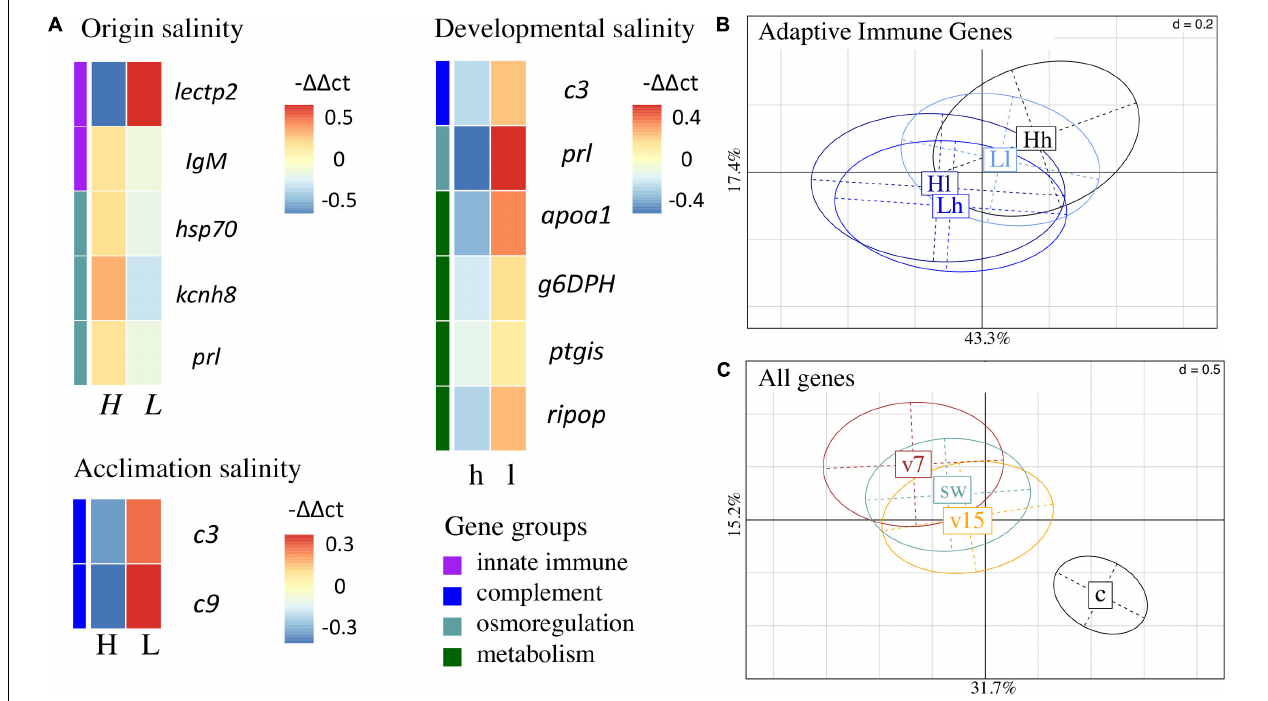
FIGURE 8 | Gene expression patterns of juveniles. (A) Non-hierarchical gene expression heatmap for genes showing differential expression (- (cid:49)(cid:49) Ct) in response to origin salinity , acclimation salinity or developmental salinity . Genes are sorted by gene groups which are assigned with different colors (purple: innate immune system, blue: complement system, turquoise: osmoregulation, green: metabolism). (B) Principal component analysis (PC1: 43.3%; PC2: 17.4%) of adaptive immune genes for significant interaction between parental acclimation salinity [H – high (15 PSU), L – low (7 PSU)] and developmental salinity (h, l). Four out of seven adaptive immune gene were upregulated ( Supplementary Figure 13 ), when parental acclimation salinity and juvenile developmental salinity did not match, i.e., Hl and Lh, compared to a matching acclimation and developmental salinity , i.e., Hh and Ll [PERMANOVA, adaptive F (1,523) = 2.6, p = 0.034]. The confidence ellipse explains 20% of the variability. (C) Principal component analysis (PC1: 31.7%; PC2: 15.2%) of gene expression patterns caused by juvenile treatment , i.e., injection with Vibrio alginolyticus evolved at 15 PSU (v15, orange), V. alginolyticus evolved at 7 PSU (v7, brown), sham injection with seawater (sw, blue, green) or untreated control (c, black). The confidence ellipse explains 20% of the variability.